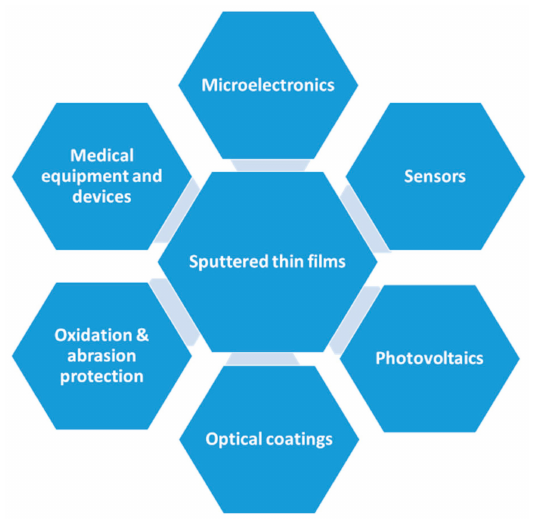
Figure 1. Spectrum of modern nanotechnological application areas reliant on sputtered thin-film